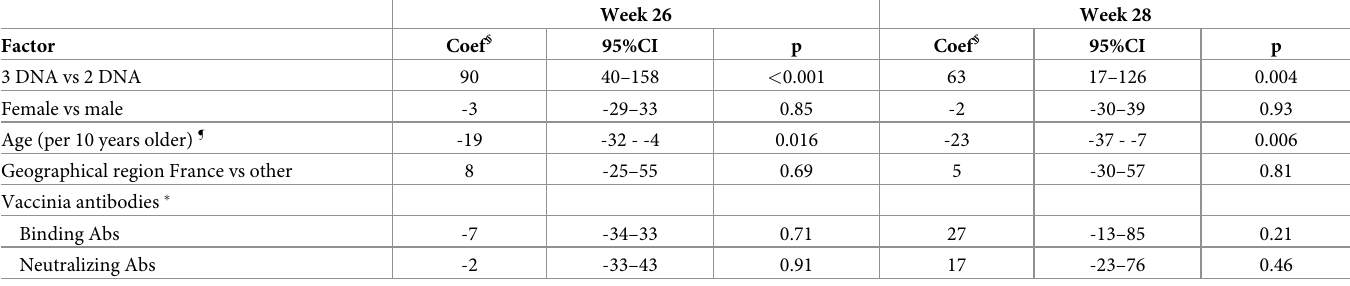
Table 4. Multivariate analysis of predictive factors of the magnitude of vaccine-elicited T cell responses, EV03/ANRS VAC20 Phase I/II